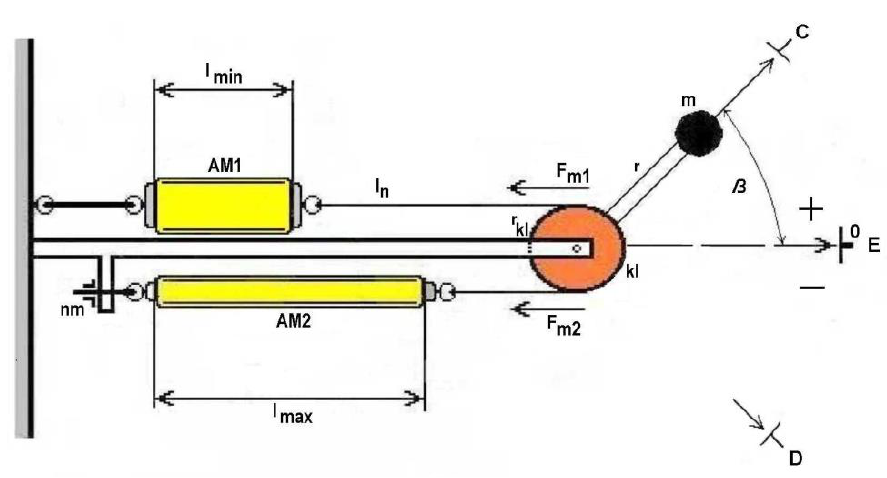
Figure 4. Pneumatic artificial muscles in antagonistic connection.